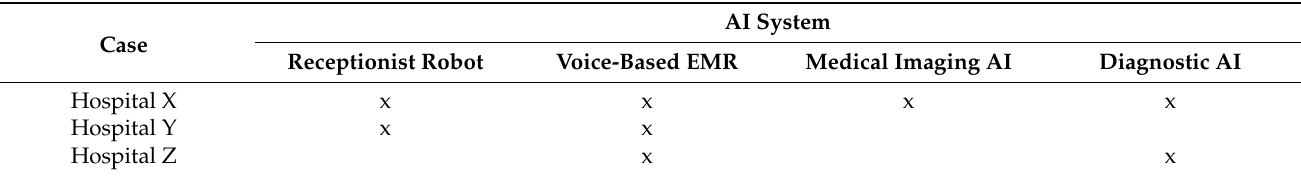
Table 1. Adopted artificial intelligence (AI) systems in the three